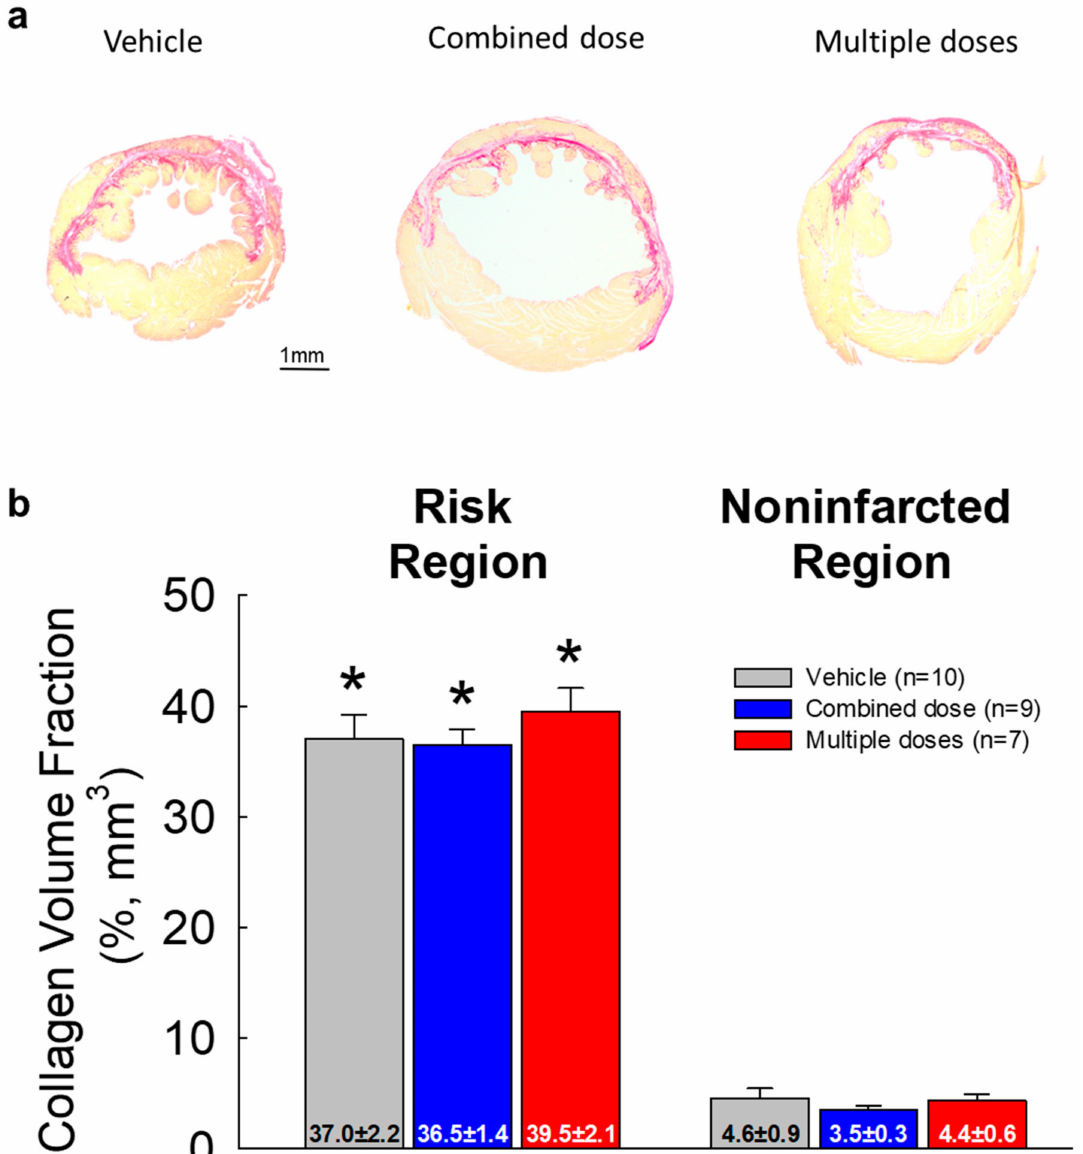
Figure 5. Myocardial collagen content ( n = 7~9/group). ( a ) Representative images of LV sections stained with picrosirius red. Images were acquired under polarized light microscopy; ( b ) quantitative analysis of collagen volume fraction (mm 3 ) expressed as a percentage of the risk and noninfarcted region. All data are represented as the mean ± SEM. * p <